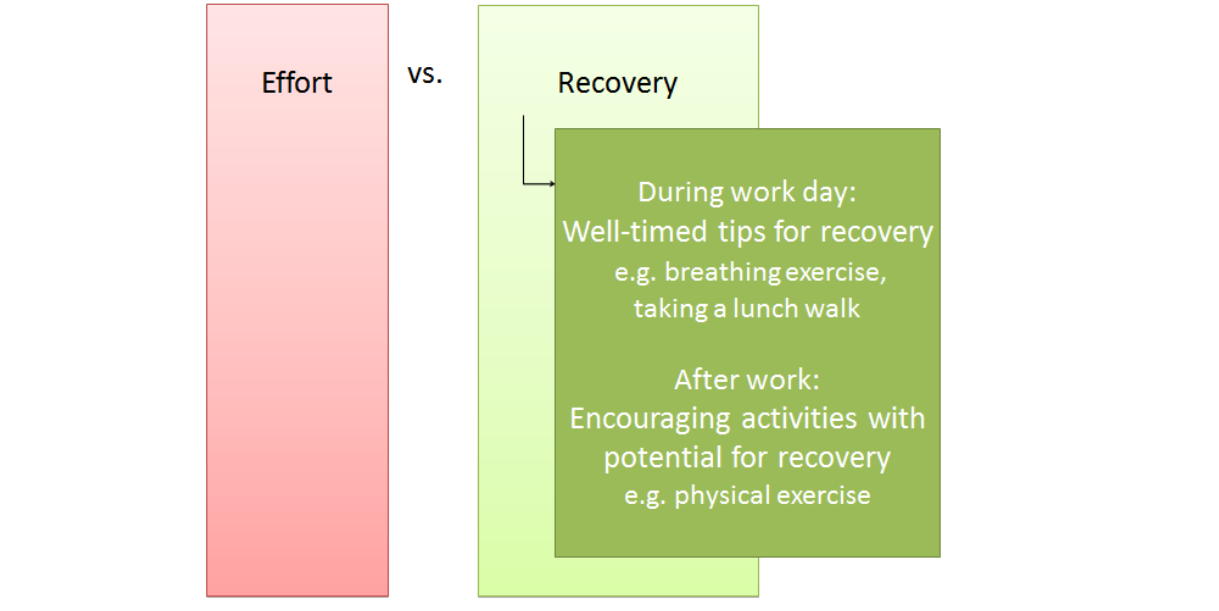
Figure 7. Effort-Recovery model [33], and possibilities for technological